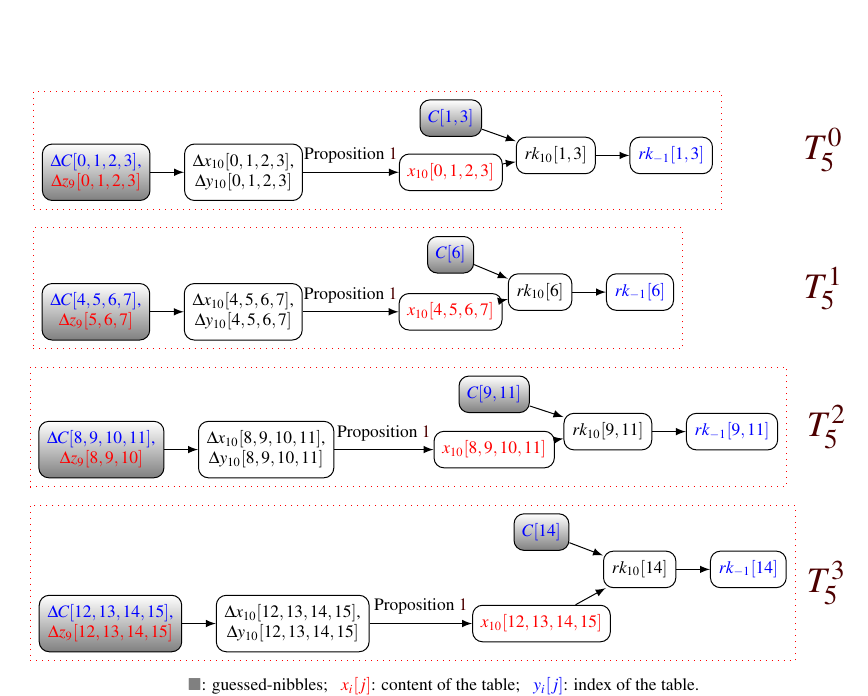
( i = 0 , ··· , 3) on the 11-round attack. There are 2 8 , 2 8 , 2 4 , 5